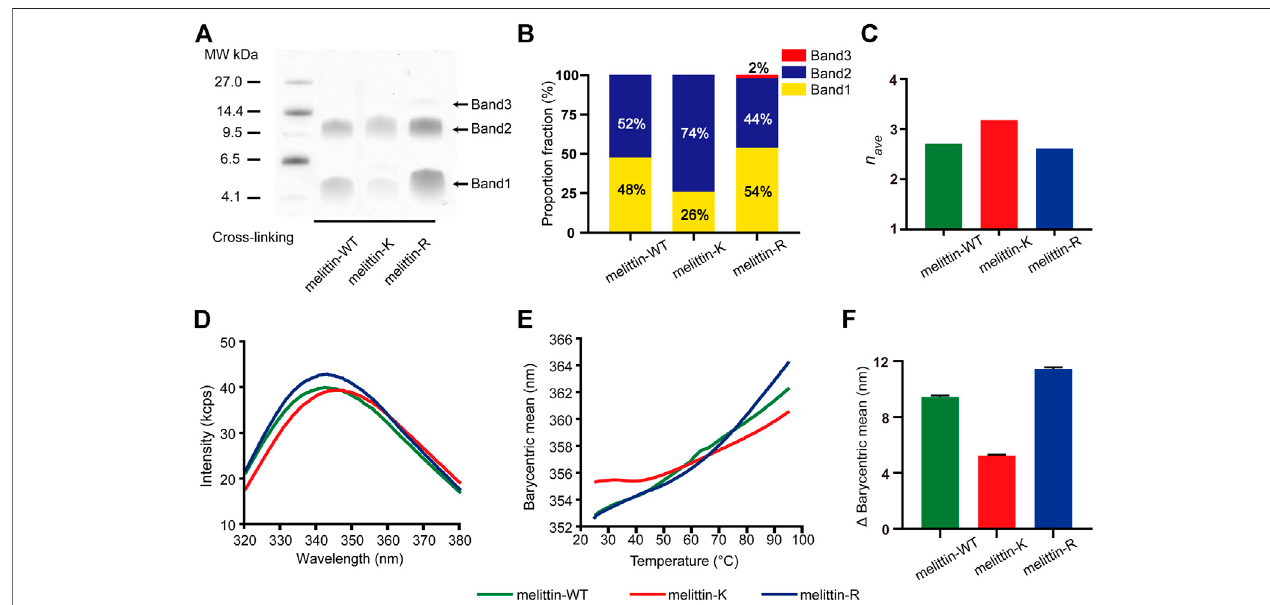
FIGURE 2 | Impacts of K vs. R on the assembly structure of melittin. (A) SDS-PAGE of melittin peptides. Band 1, band 2, and band 3 are corresponding to dimer, tetramer, and hexamer, respectively. (B) The proportion fraction of band intensity ( p i , i (cid:2) 2, 4, and 6 for dimer, tetramer, and hexamer, respectively). (C) The averaged degree of oligomerization ( n ave ) of melittin peptides. (D) The tryptophan intrinsic fl uorescence spectrum of melittin peptides at 25 ° C. (E) The barycentric mean of the melittin intrinsic fl uorescence spectrum changes with temperature. (F) The variation of BCM from 25 to 95 °